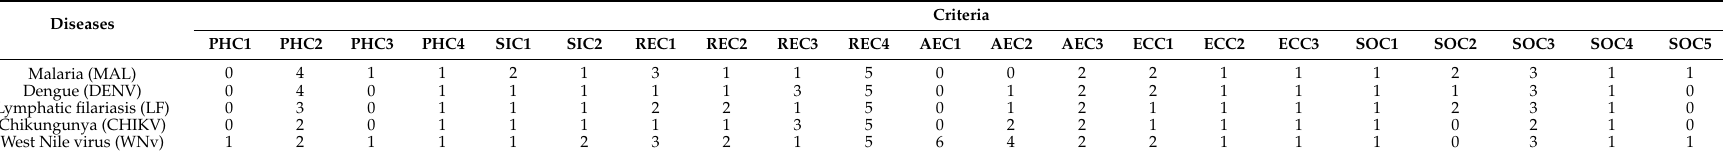
Table 3. Pilot climate sensitive infectious disease criteria evaluations for Quebec (disease evaluation matrix showing evaluation scores for each of the five pilot diseases based on context specific data reviewed pertaining to each disease over all